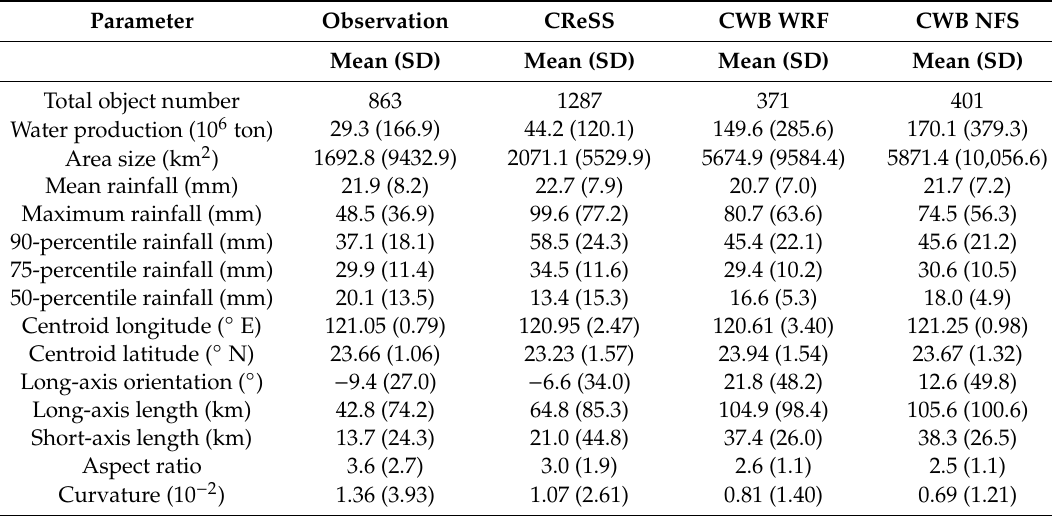
Table 2. Mean value and standard deviation (SD) of major parameters and attributes of rainfall objects in observation, and CReSS, CWB WRF, and CWB NFS forecasts initialized at 0000 UTC. The model forecast range used is 12–36 h, and SD values are given in